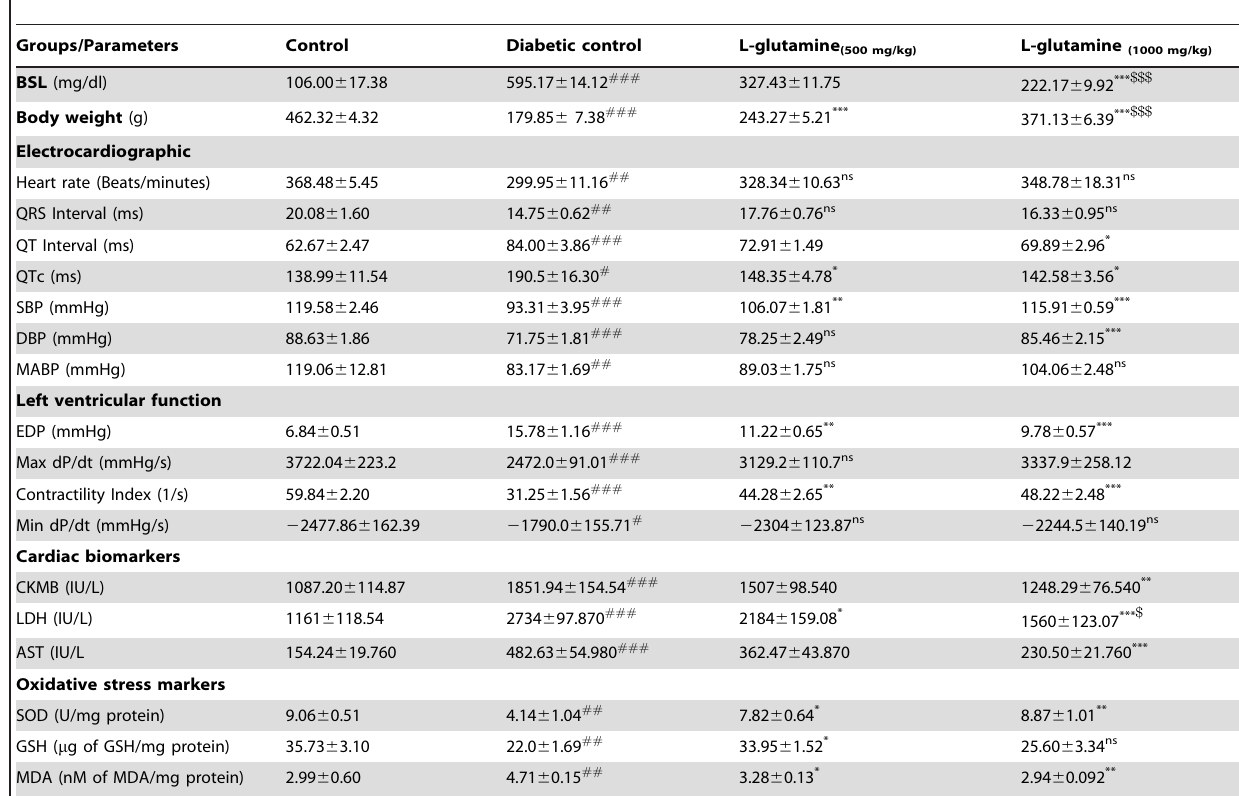
Table 1. Effect of L-glutamine on electrocardiographic, hemodynamic, Left ventricular function parameters and heart antioxidant enzymes in STZ-nicotinamide induced cardiomyopathy in